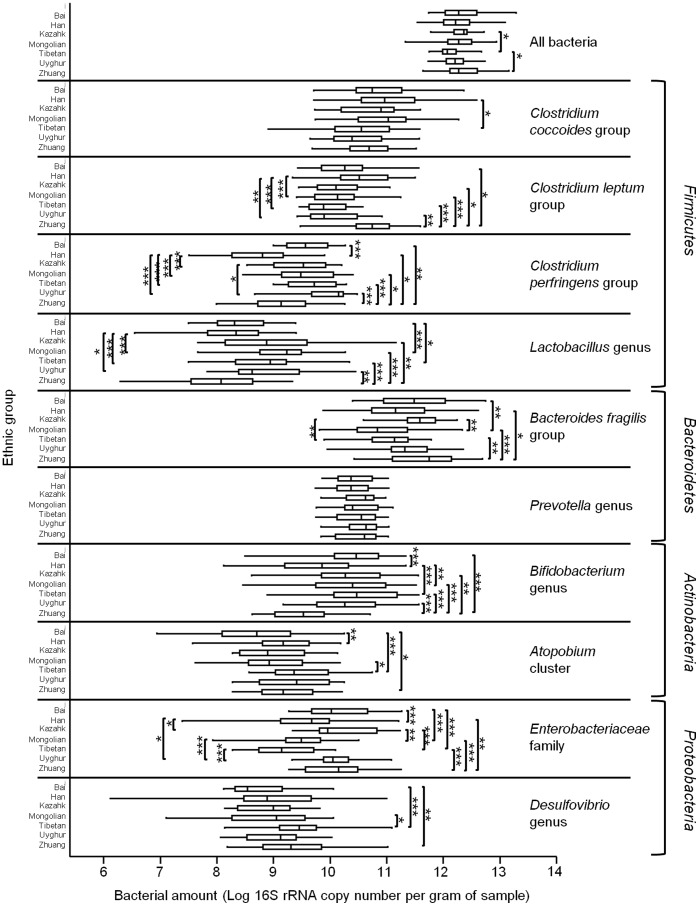
Box plots showing fecal bacterial composition of different ethnic groups.Bacterial amounts are expressed in Log 16S rRNA copy number per gram of fecal sample. Boxes show the median, 25th and 75th percentiles. The lower and upper adjacent hinges show the minimum and maximum values. The significant difference between sample pair was evaluated by pairwise Mann-Whitney test with Bonferroni correction. A corrected p-value <0.05, 0.01 and 0.001 are denoted by ‘*’, ‘**’, and ‘***’, respectively. The obtained p-values are given in Table S3.